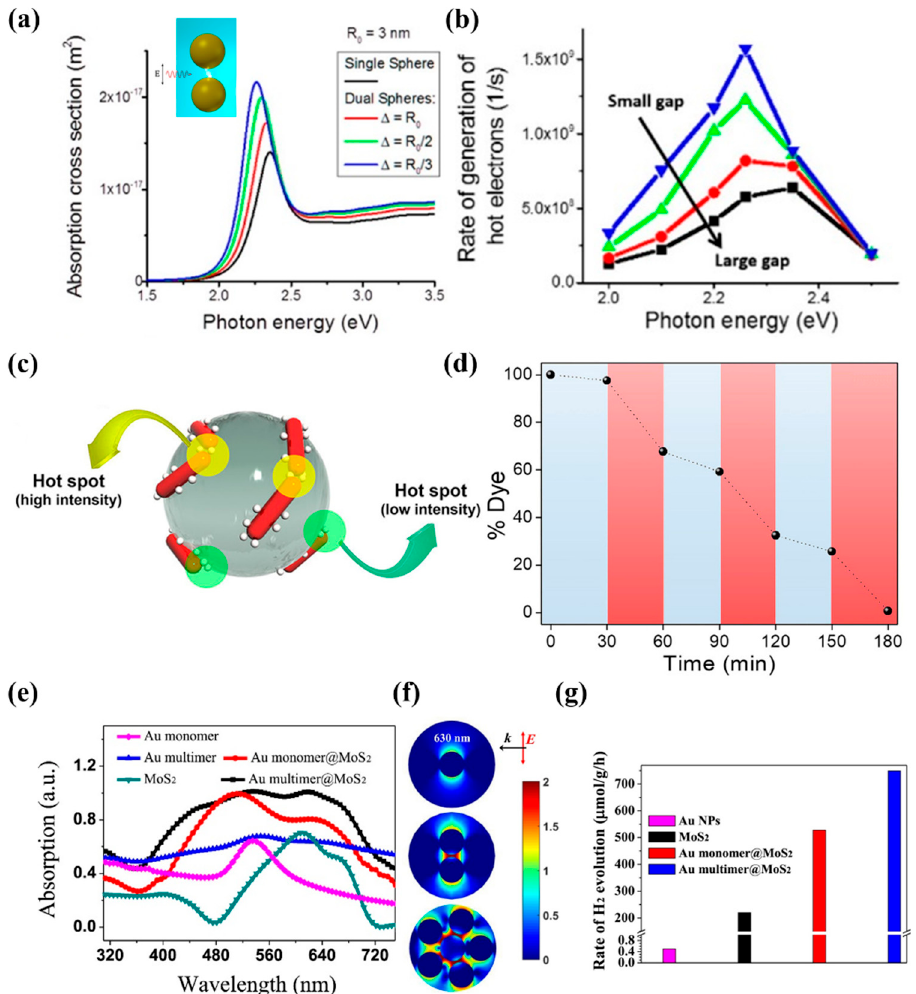
Figure 4. “Gap hot spots” designed for an efficient photocatalytic process. ( a ) Calculated optical absorption cross section in a single Au sphere and Au nanodimers with different gap spaces. ( b ) The theoretical relationships between the rates of generation of HCs and the gap space. ( a , b ) Reproduced with permission. [69] Copyright 2016, American Chemical Society. ( c ) The scheme of “hot spots” structures built up by Au rods-TiO 2 /thermoresponsive polymer and ( d ) the rates of degradation of RhB under 25 °C (blue regions) and 40 °C (red regions). ( c , d ) Reproduced with permission. [70]